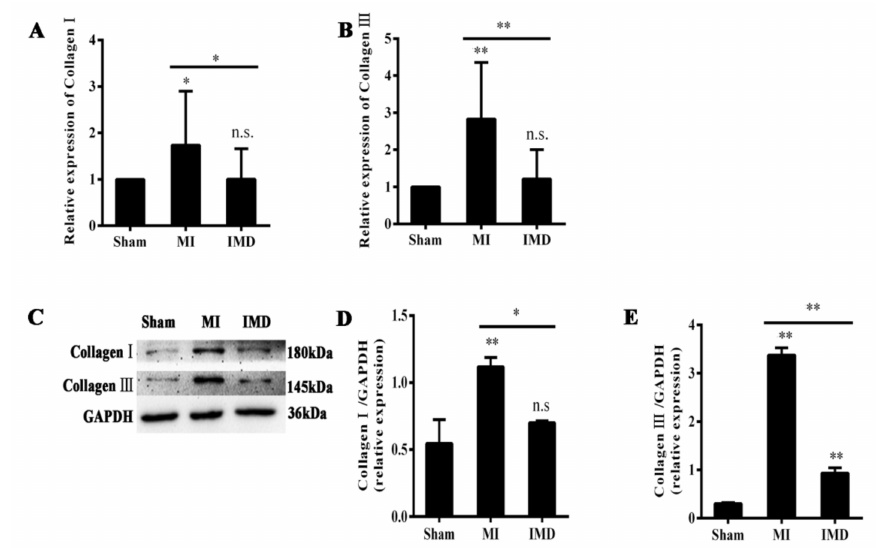
Figure 4. mRNA and protein expression of collagen I and collagen III in the left atria of rats. ( A ) mRNA expression of collagen I. IMD1-53 decreased collagen I after MI. ( B ) mRNA expression of collagen III. IMD1-53 decreased collagen III after MI. ( C ) Western blot of collagen I and collagen III. ( D ) Bar graphs indicate Western blot analysis for the protein expression of collagen I. IMD1-53 decreased the protein level of collagen I in the left atrium. ( E ) Bar graphs indicate Western blot analysis for the protein expression of collagen III. IMD1-53 decreased the protein level of collagen III in the left atrium. Data in bar graphs are means ± SD, n = 10. * p < 0.05, ** p < 0.01. n.s., no